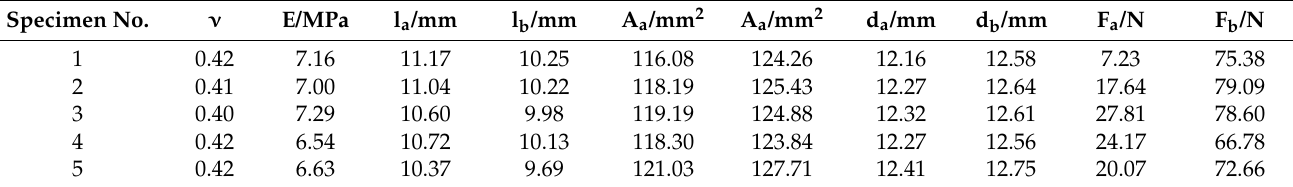
Table 1. The calculation parameters of the Poisson’s ratio ( ν ) and Young’s modulus ( E